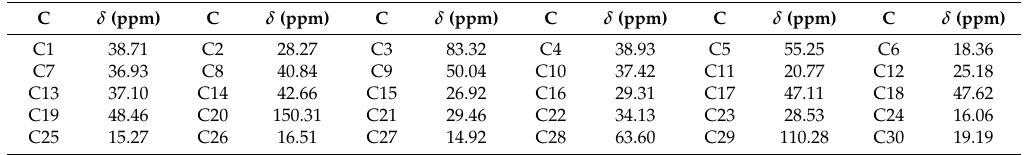
Table 1. Carbon-13 nuclear magnetic resonance ( 13 C-NMR) spectral data of